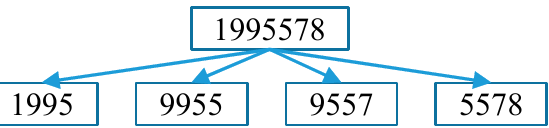
Figure 18 . Cutting process for ear tags with length of more than ‘3’. Figure 18. Cutting process for ear tags with length of more than ‘3’.